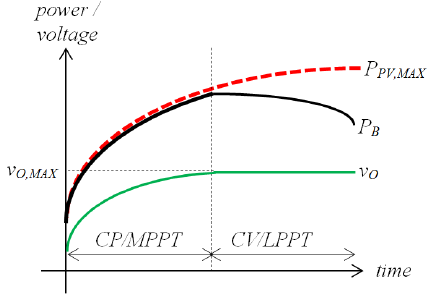
Figure 6. Operating